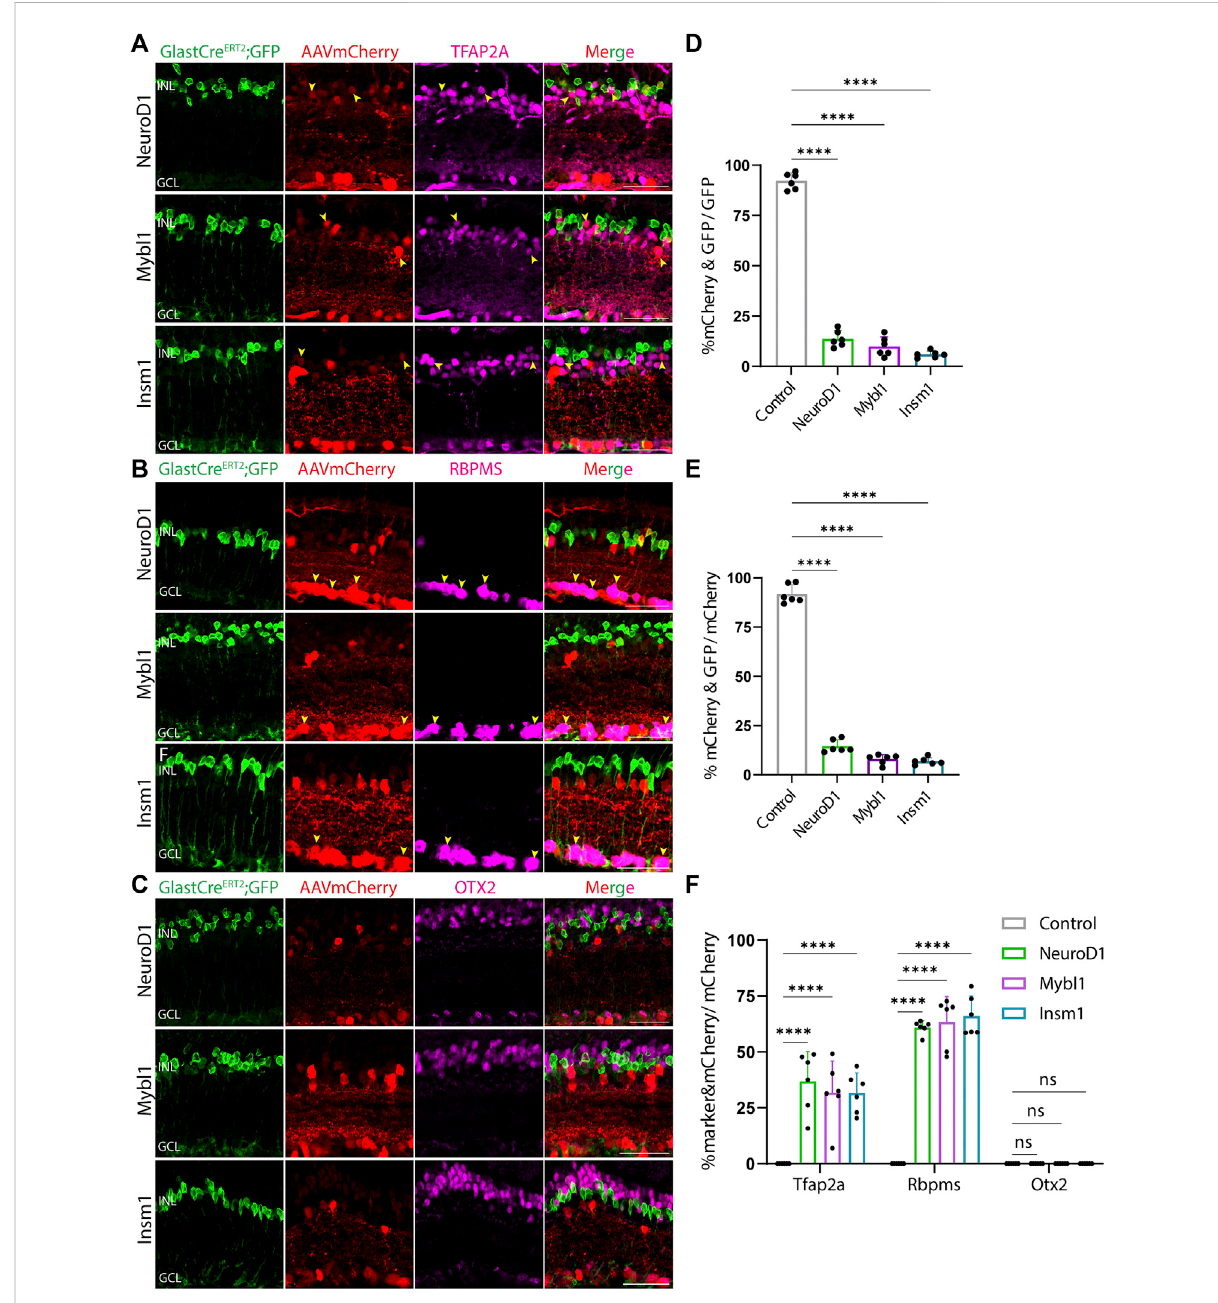
FIGURE 3 GFAP promoter constructs expressing NeuroD1, Mybl1 and Insm1 show ectopic mCherry expression in amacrine and ganglion cells. Representative immunostaining for GFP, mCherry and 3 neuronal markers: (A) Tfap2a, (B) Rbpms, and (C) Otx2 expression in the retinas collected 21 days post GFAP AAV infection. GFAP-NeuroD1-mCherry, GFAP-Mybl1-mCherry and GFAP-Insm1-mCherry showed little to no colocalization of construct-derived mCherry and Müller glia-speci fi c Sun1-GFP. High levels of mCherry expression in amacrine and ganglion cells, but not in bipolar cells were observed in retinas infected with these GFAP AAV constructs. Yellow arrowheads indicate co-labeled mCherry+ & marker + cells. Quanti fi cation of transduction ef fi ciency (mCherry+ & GFP + cells/GFP + cells) (D) and transduction speci fi city (mCherry+ & GFP + cells/mCherry + cells) (E) . Quanti fi cation of mean percentage ±SD of marker & mCherry+/GFP cells: Tfap2a+ & mCherry+/GFP + cells (in INL and GCL), Rbpms+ & mCherry+/GFP+cells(inGCL)andOtx2+&mCherry+/GFP +cells(inINL) (F) .Signi fi cancewasdetermined via one-wayANOVAortwo-wayANOVA with Dunnett ’ s test: **** p < 0.0001. Each data point in the bar graphs was calculated from an individual retina ( n = 6). INL, inner nuclear layer; GCL, ganglion cell layer. Scale bar = 40 μ